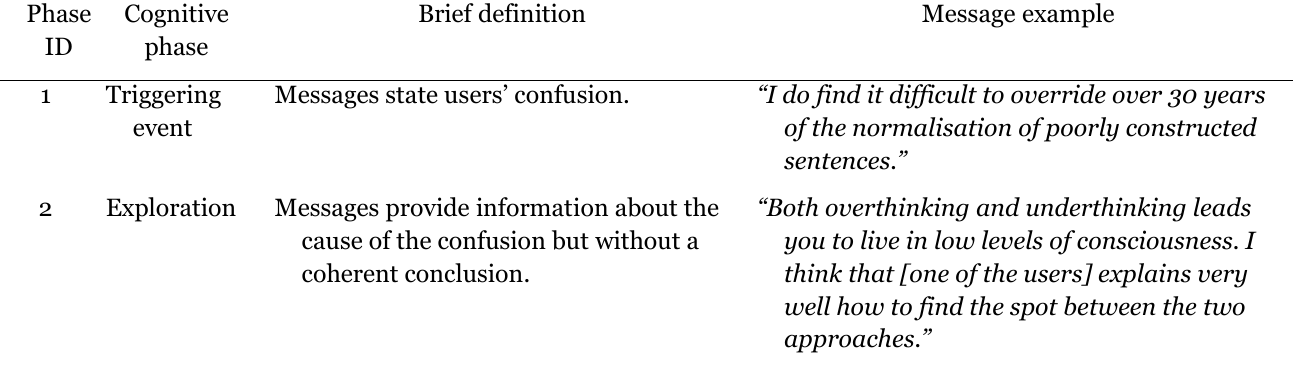
Definitions with Message Instances of the Five Categories in Cognitive Presence